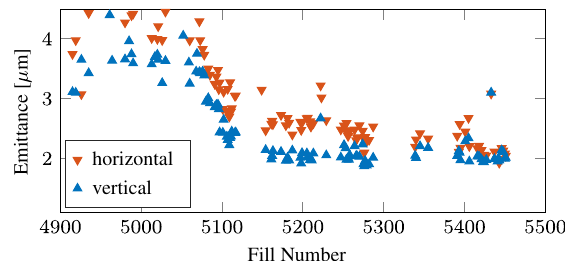
FIG. 10. The average horizontal and vertical emittances at the start of collisions in 2016 proton physics